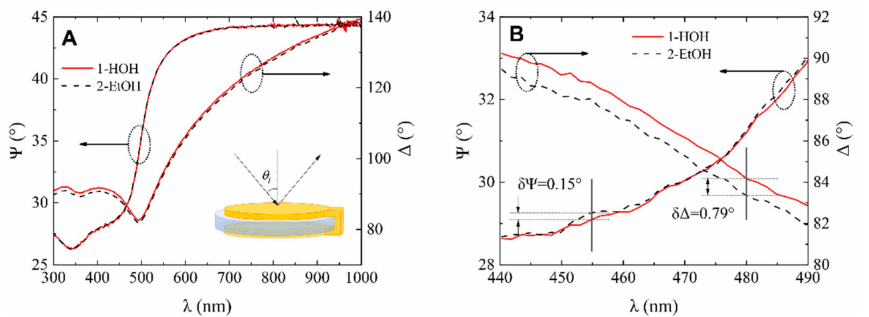
Figure 4. ( A ) Ellipsometric parameter dependence on wavelength λ for (1) QCM-D sensor disc in water and (2) QCM-D chip in ethanol, ( B ) zoomed view of ellipsometric parameters Ψ and ∆ dependence on wavelength λ for (1) QCM-D chip in water (red curves) and (2) QCM-D chip in ethanol (dashed curves) with sensitivity parameters δ Ψ and δ ∆ .